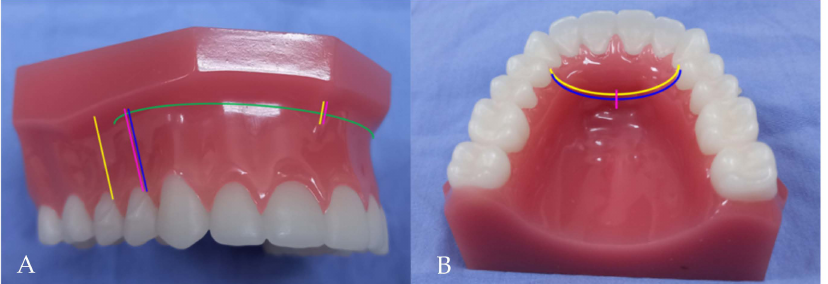
Figure 1. Four different anterior maxillary subapical osteotomies (AMSO). Yellow line: present study (Modified AMSO); Green line: Cupar method; Blue line: Wunderer method; Pink line: Wassmund method. ( A ) Vestibular incisions ( B ) Palatal mucosal